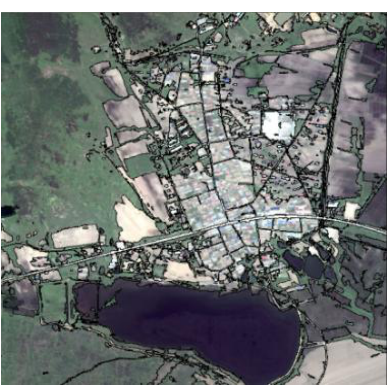
Figure 6.Road Figure 7.Building